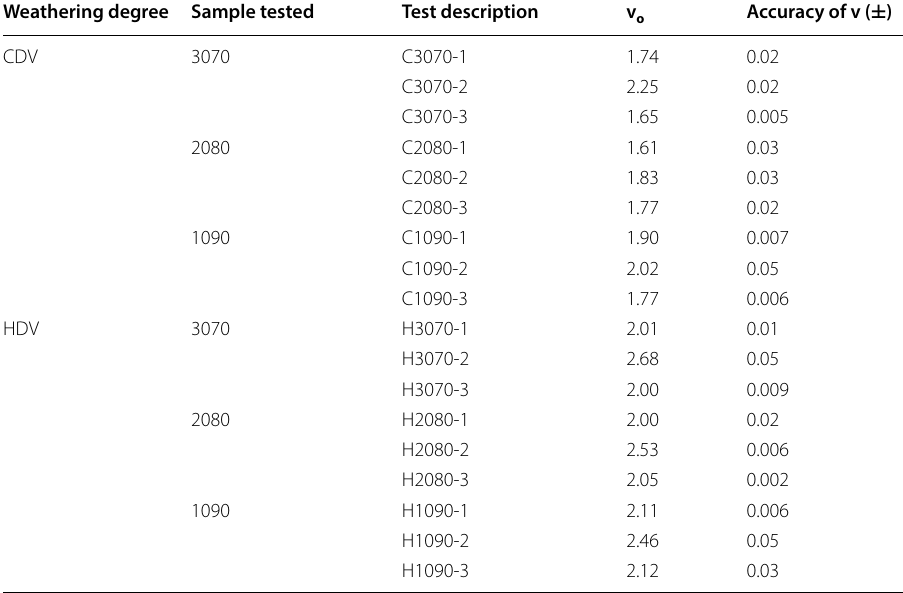
v o initial specific volume, v specific volume, C completely decomposed, H highly decomposed